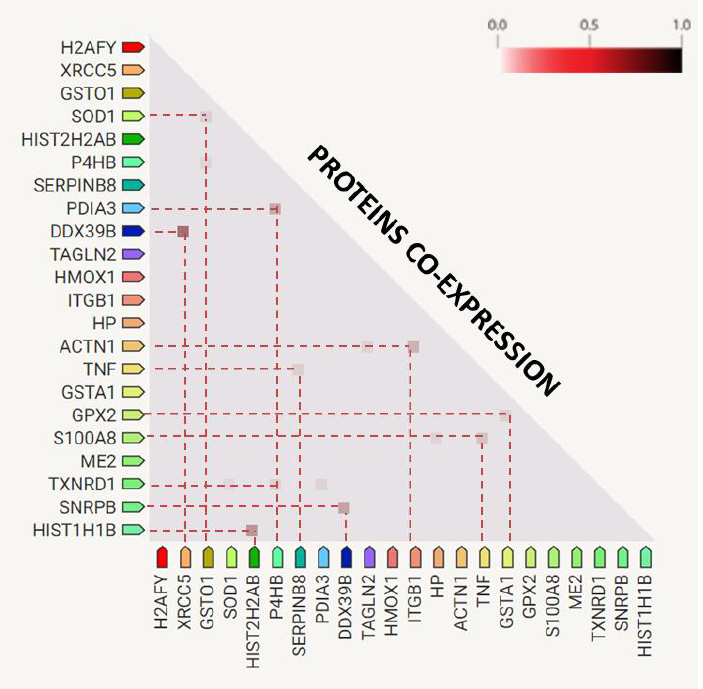
Figure 5. Co-expression of top significantly modified proteins identified in the plasma samples of the control group (CTR), patients with tick-borne encephalitis (TBE), and patients with TBE and co- infection (TBE+LD). The separate lines are used to mark proteins with the highest co-expression (>0.5).